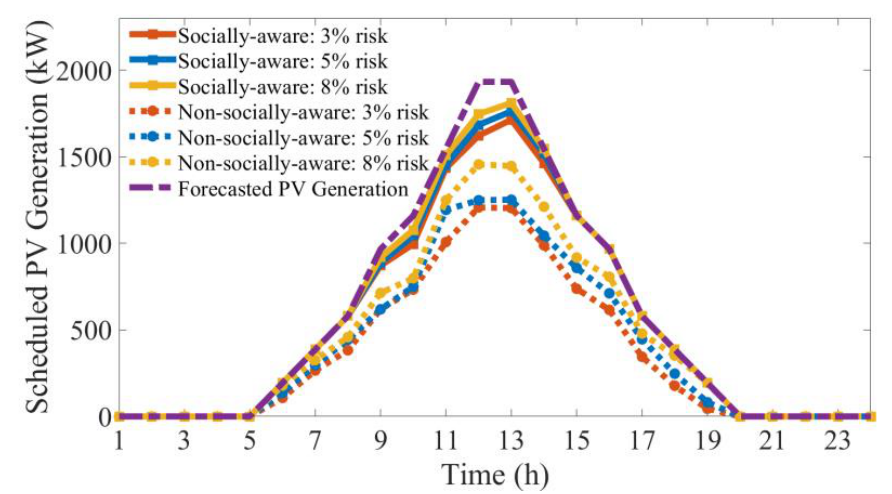
Figure 6. Scheduled PV generation for Case I with PV reserve policy of 10%.